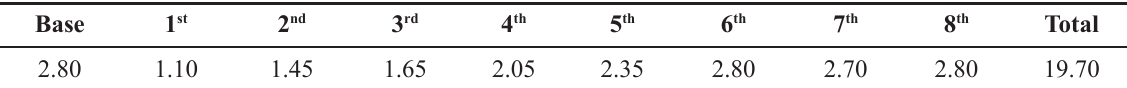
Table 4. Plusiocampa ( Plusiocampa ) chiosensis Sendra & Gasparo sp. nov. Length of one cercus in the holotype (MZB 2019-1030) (measurments in